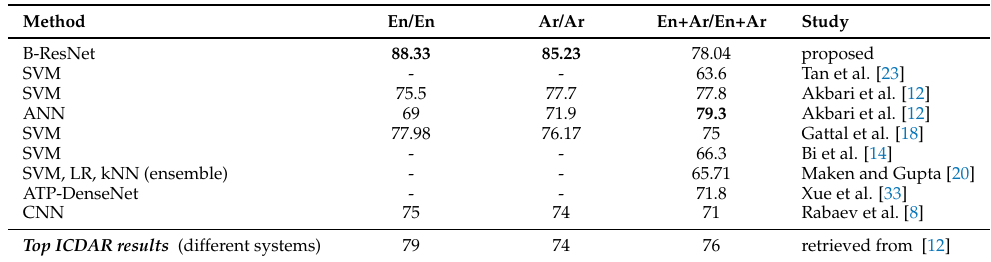
Table 3. Comparison of classification accuracy (%) for gender classification on the ICDAR 2013 dataset.